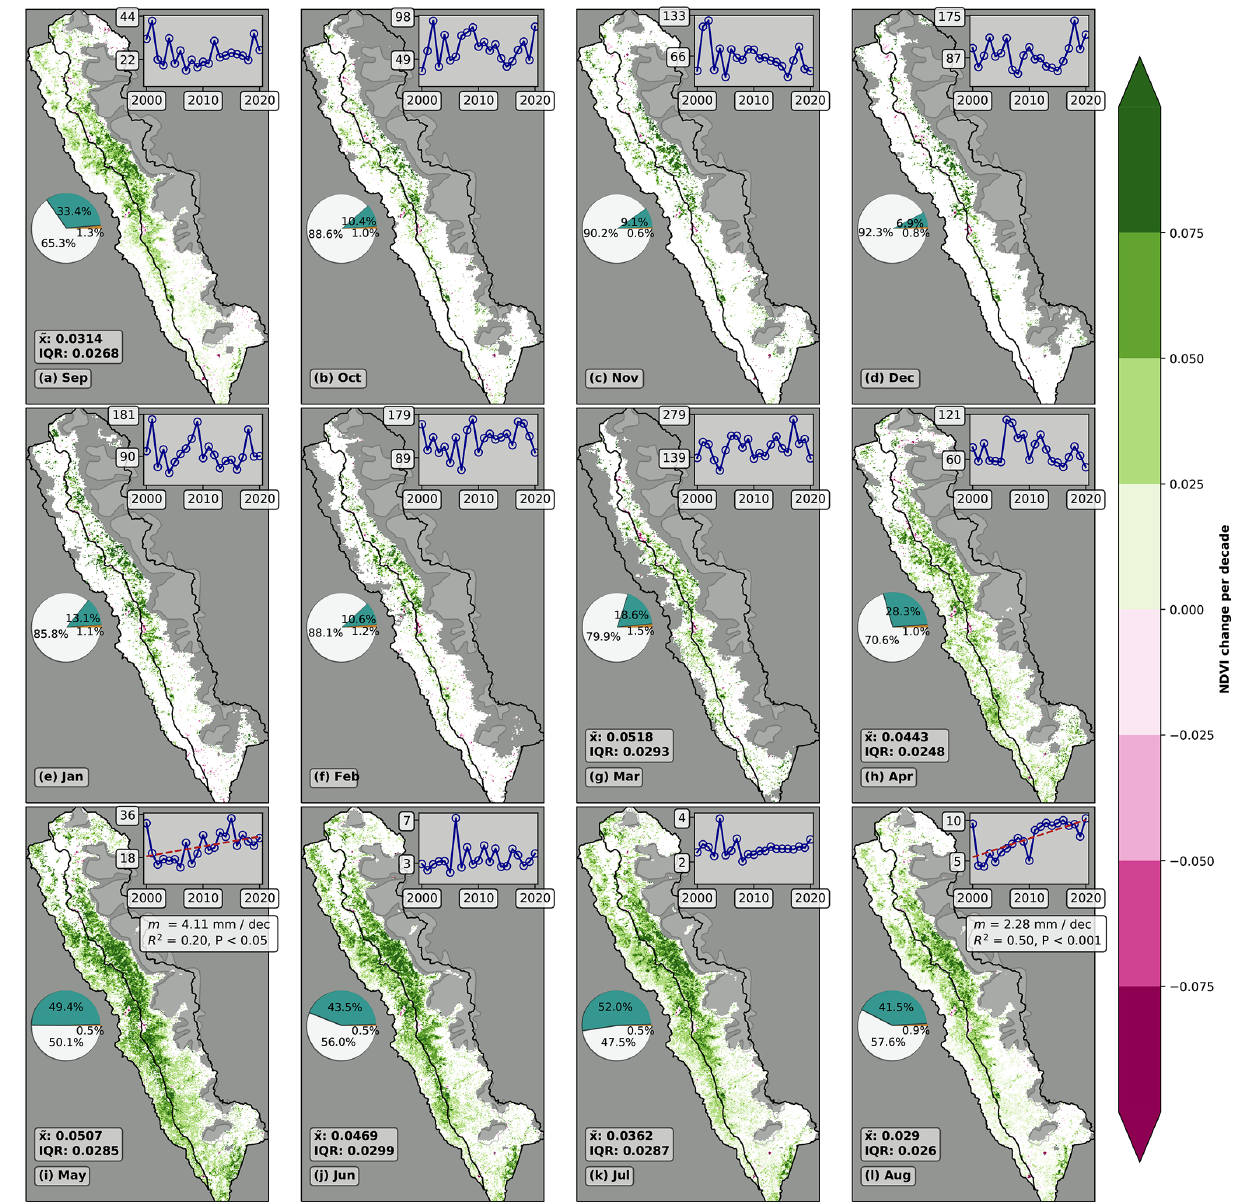
Figure 4. Monthly greening and browning of NDVI. For months with at least 15% significant pixels, median slopes values ( ˜ x ) and interquar- tile ranges (25%–75%) are shown. Only significant pixels ( P < 0.05) are shown; white color indicates non-significant pixels, while gray areas correspond to no data due to frequent cloud cover or excluded land cover. Pie charts show relative frequencies of greening, browning and non-significant pixels. Small panels (blue line plots) show domain mean CHIRPS rainfall data for the respective month and additionally decadal slope (m) and linear regression statistics for significant ( P < 0.05)